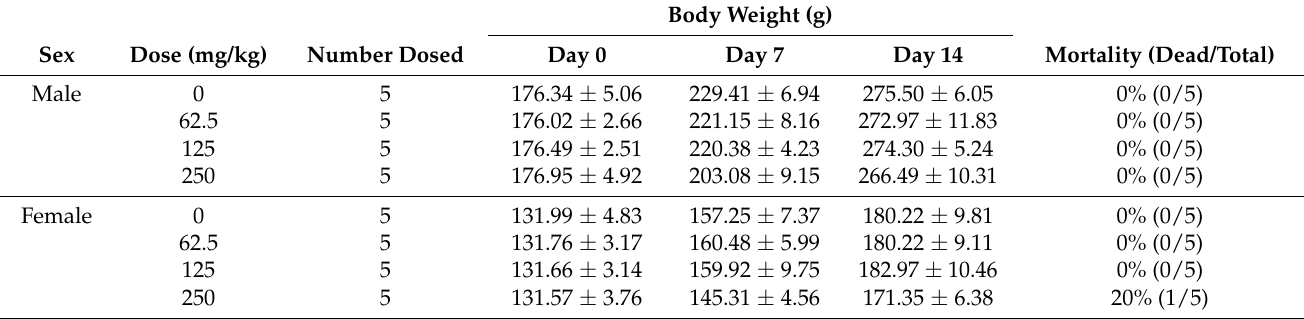
Table 1. The body weight and mortality of rats during the single-dose toxicity study. Body Weight (g)